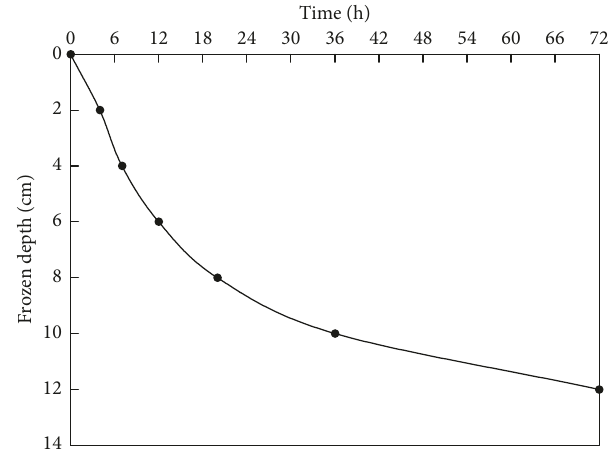
Figure 10: Variation of frozen depth with time.